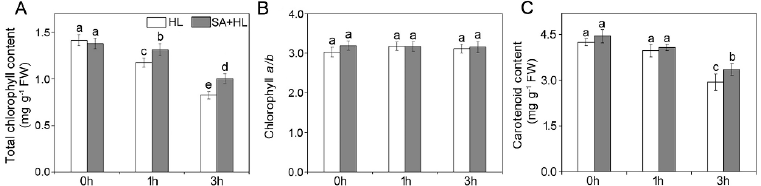
Figure 1. Effects of SA on total chlorophyll content ( A ), chlorophyll a / b ratio ( B ), and carotenoid content ( C ) in Arabidopsis thaliana under high light. The data represent means ± SD (standard deviations) from four independent biological replicates ( n = 4). Different lower ‐ case letters indicate significant di ff erences ( p < 0.05) according to Duncan’s multiplication range test. HL, high light. SA + HL,